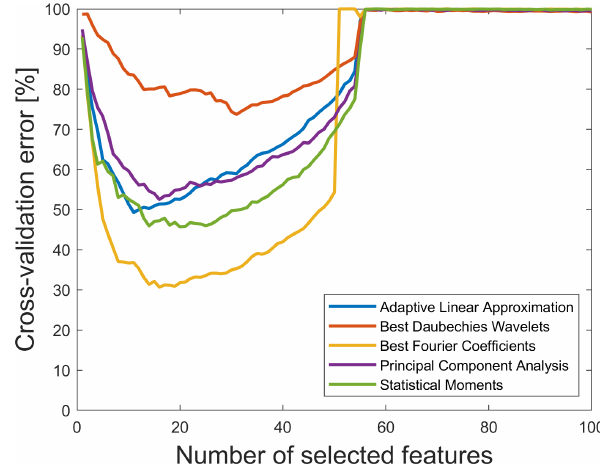
Figure 9. Cross-validation errors vs. the number of selected BFC features for different random simulated synchronization errors us- ing RFESVM as selector.